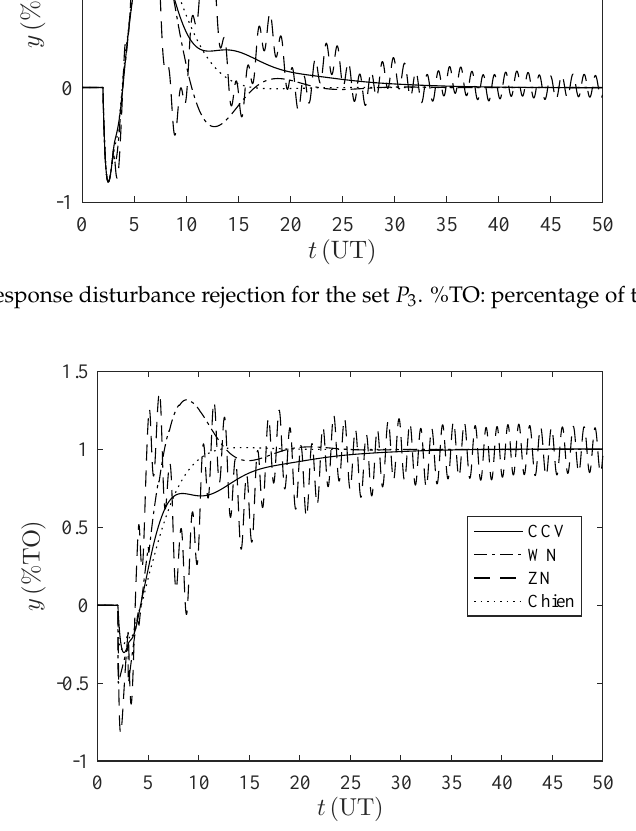
Figure A6. Time response set-point tracking for the set P 3 . %TO: percentage of transmitter output, UT: units of